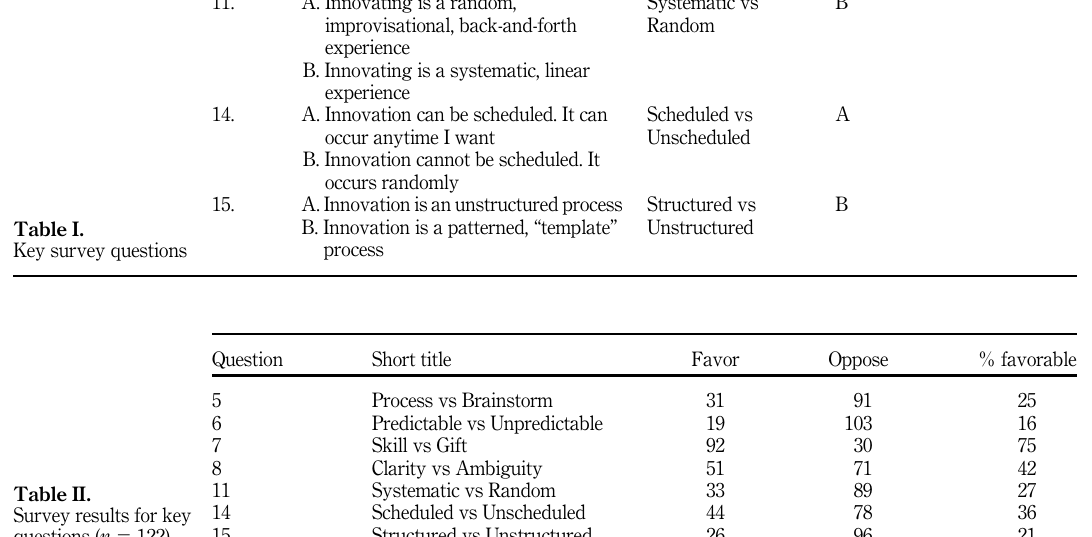
Table II. Survey results for key questions ( n 5